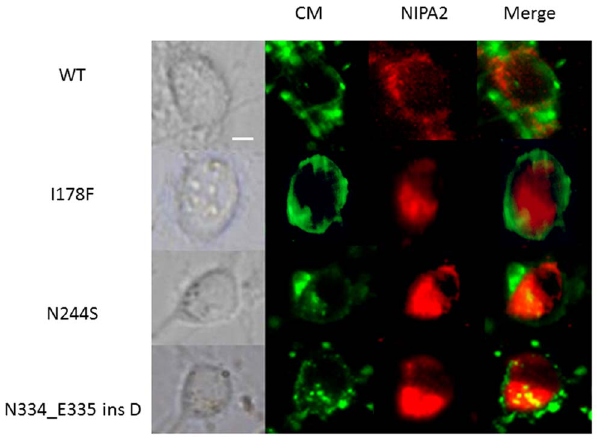
Figure 1. The localization of NIPA2-WT and the mutants in cultured neurons. CM: cytomembrane marked by DIO (a cytomem- brane marker, green); NIPA2 was labeled by red fluorescence. MERGE: overlapped image. WT: wild-type. NIPA2-WT proteins (red) were distributed at cytomembrane, overlapped with DIO (green), but the three mutant proteins (I178F, N244S, N334_E335insD; red) were trapped in cytoplasm and showed no overlap with the plasma membrane. n=4 experiments, scale bar: 5 m m.